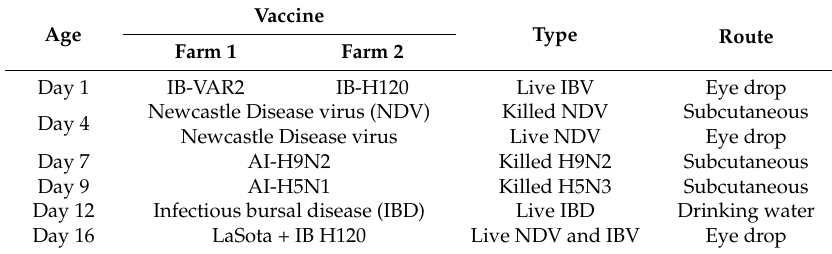
Table 1. Vaccination programs adopted in the studied commercial broiler flock. IBV: infectious bronchitis virus. AI: avian